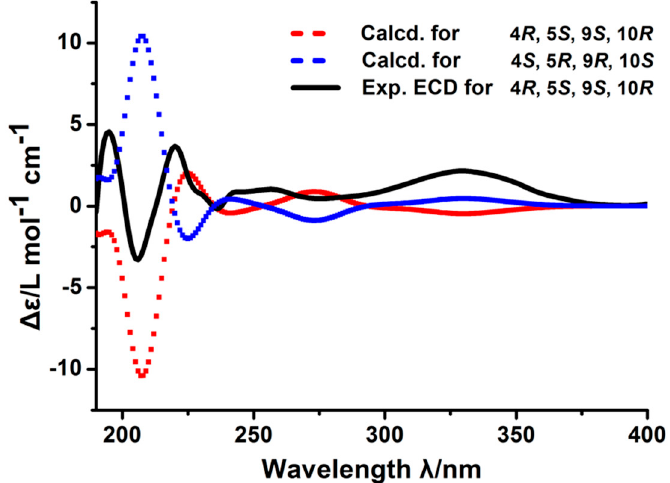
Figure 2. Some of the key correlations observed for compound 1 . ( a ) 1 H- 1 H COSY (bold) and key HMBC (red single headed) correlations of compound 1 . ( b ) NOESY (blue single headed) correlations of compound 1 .